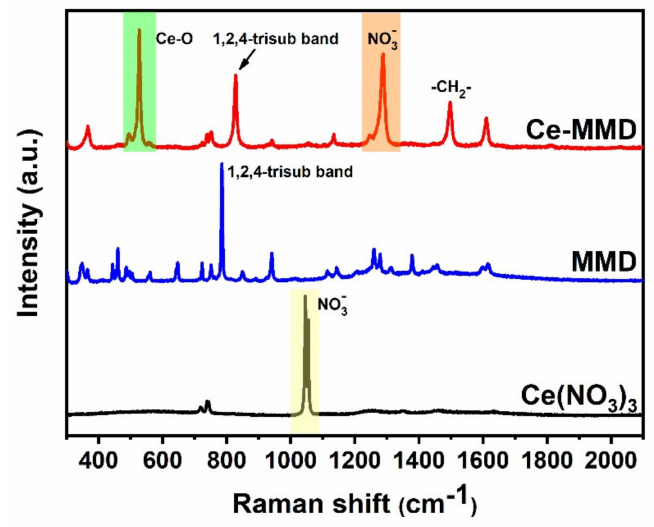
Figure 9. FT-Raman spectra of cerium(III) nitrate hexahydrate, the MMD ligand, and the Ce-MMD complex.